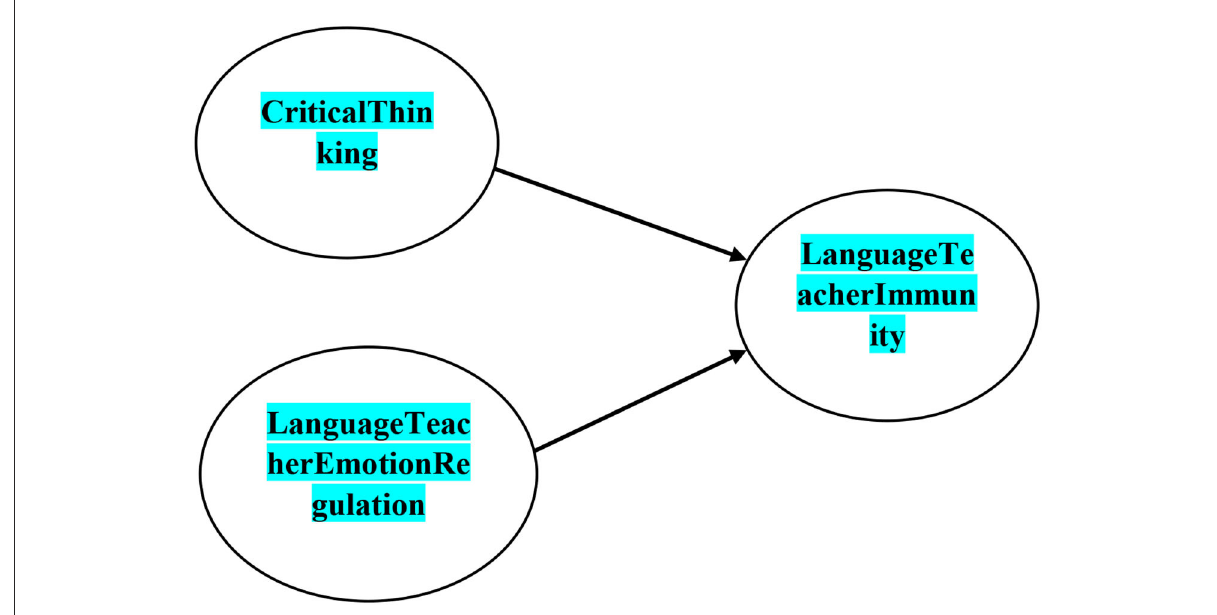
FIGURE1 Theoretical structural equation